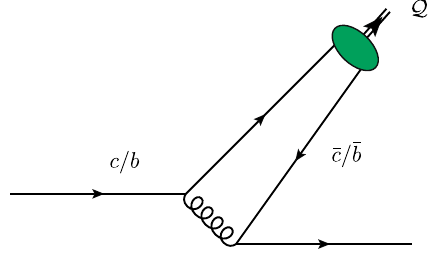
( 1 ) to 3 S vector quarkonium Q at order α 3 s . The green blob denotes the 1 corresponding non-perturbative NRQCD LDME